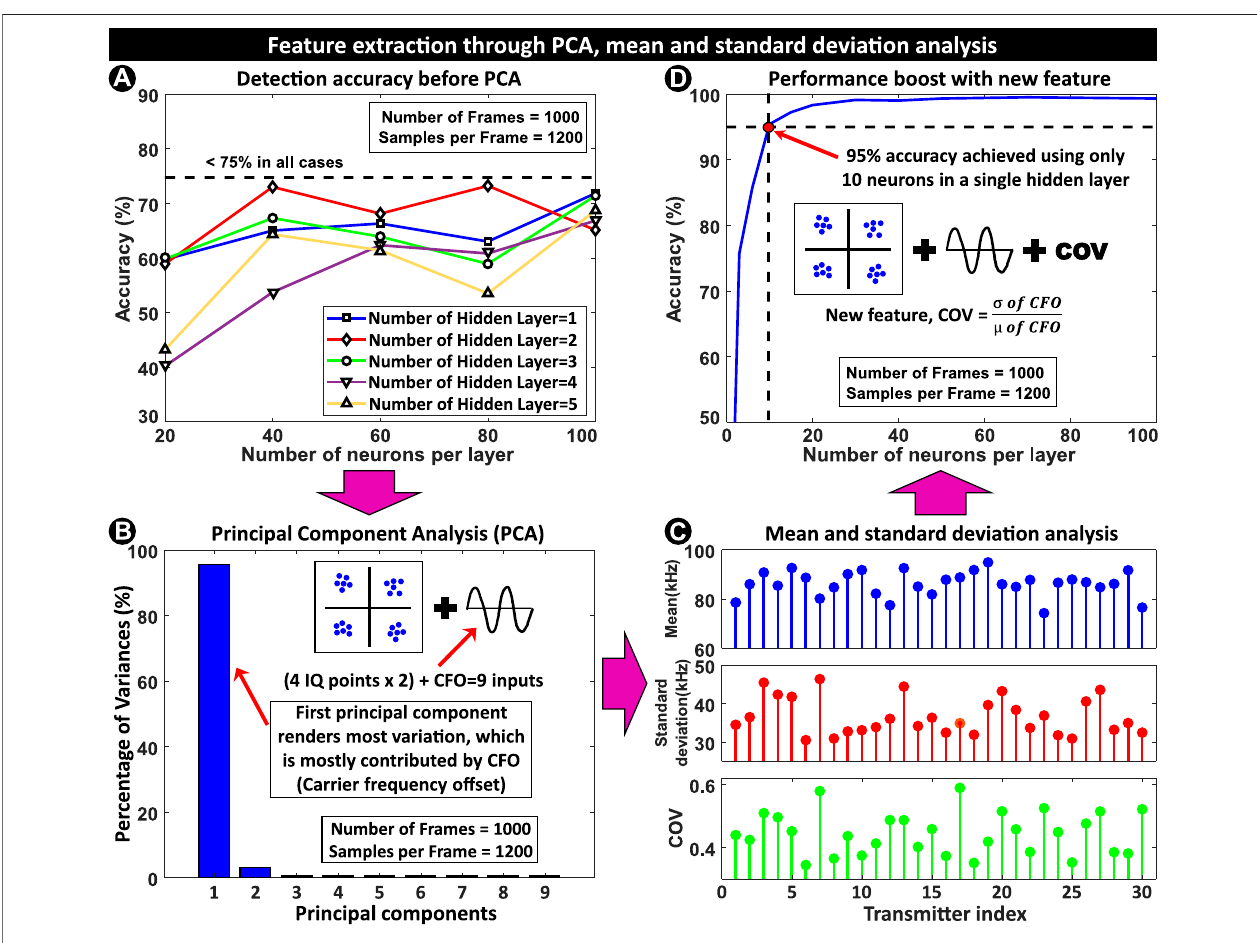
FIGURE 4 | (A) Accuracy vs. the number of neurons in each hidden layer. Even after increasing the number of hidden layers, the accuracy remains < 75 % . (B) Principal Component Analysis (PCA) reveals that the fi rst principal component (PC) causes most variation, which in turn depends mostly on the carrier frequency offset, CFO. (C) Mean ( μ ) and standard deviation ( σ ) of the dominant feature (CFO) were analyzed in search of a new feature. It reveals that these statistical parameters vary signi fi cantlyamongtransmitters.So,theirratioorcoef fi cientoffrequencyoffsetvariation,COV= standarddeviation ( σ ) ofCFO istakenasthe10 th feature. (D) Theinclusion mean ( μ ) ofCFO of COV shows signi fi cantimprovement in the detection accuracy. Using asingle hidden layer with only 10 neurons, 95 % accuracy isachieved, and > 99 . 8 % accuracy is reached for > 50